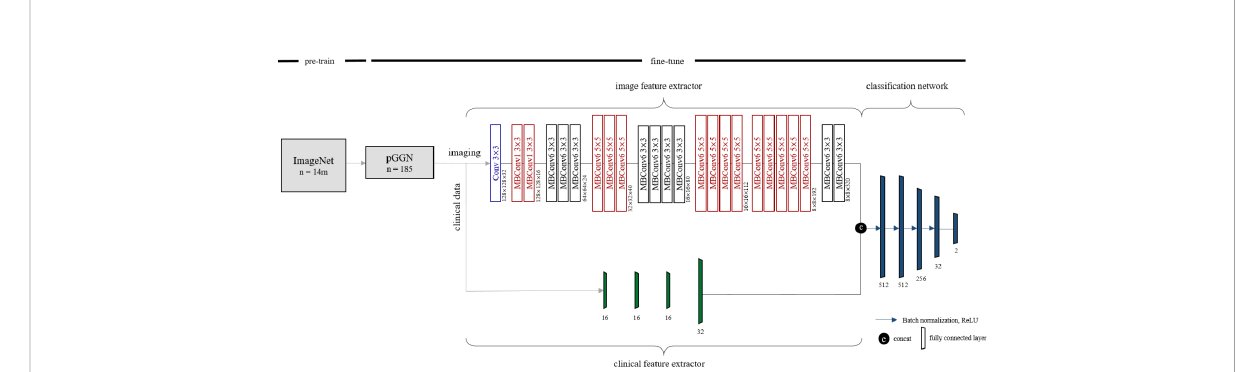
FIGURE 2 Details of Multimodal Ef fi cientNet-b1 for Lung. Multimodal Ef fi cientNet-b1 for Lung (MENL) consists of an image feature extractor, clinical feature extractor, and classi fi cation network. Pre-trained Ef fi cientNet-b1 was used as an image feature extractor. For Ef fi cientNet-b1, MBConv1 and MBConv6 were utilized as basic modules. MBConv1 was composed of depth-wise convolution, SENet (35), and 1×1 convolution. For MBConv6, 1×1 convolution was added before depth-wise convolution of